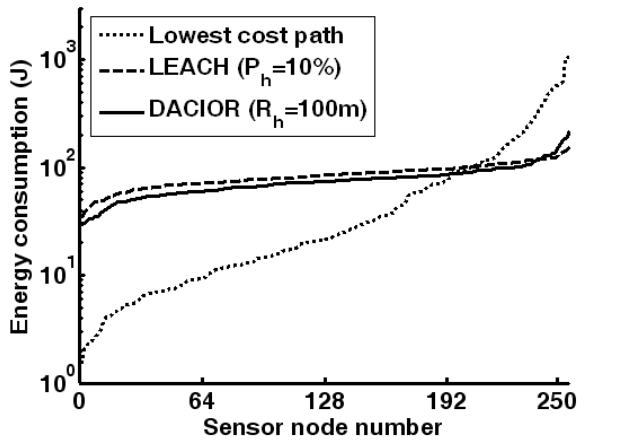
Figure 7. Energy consumption of each sensor node after target tracking with lowest cost path, LEACH and